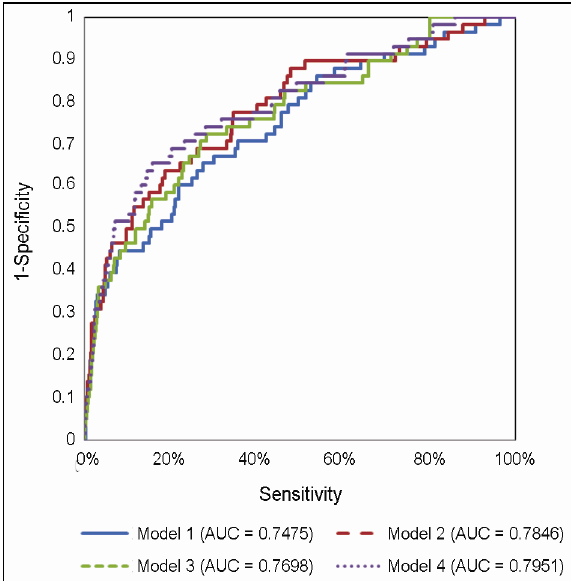
Fig. 2. ROC curves for multivariate Logit models on prior two-year